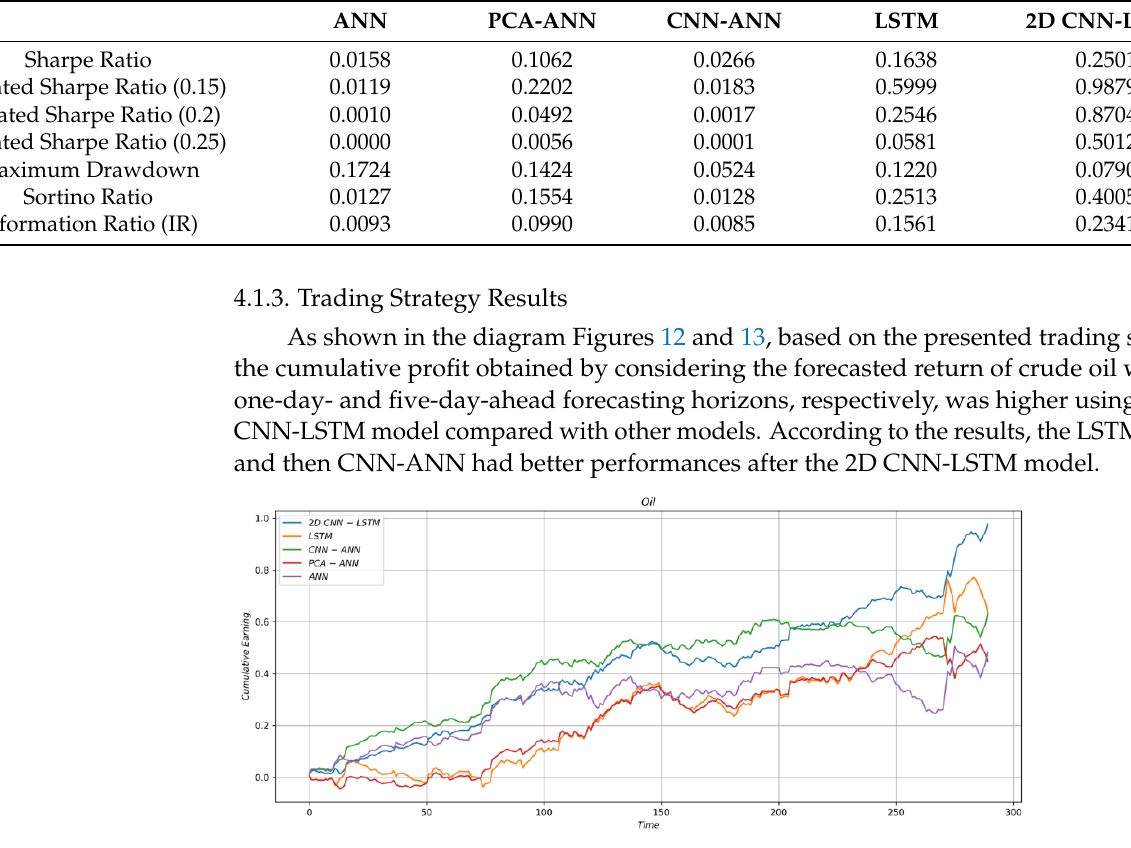
Table 14. The Amount of Each Measure with Five-Day-Ahead Forecast.